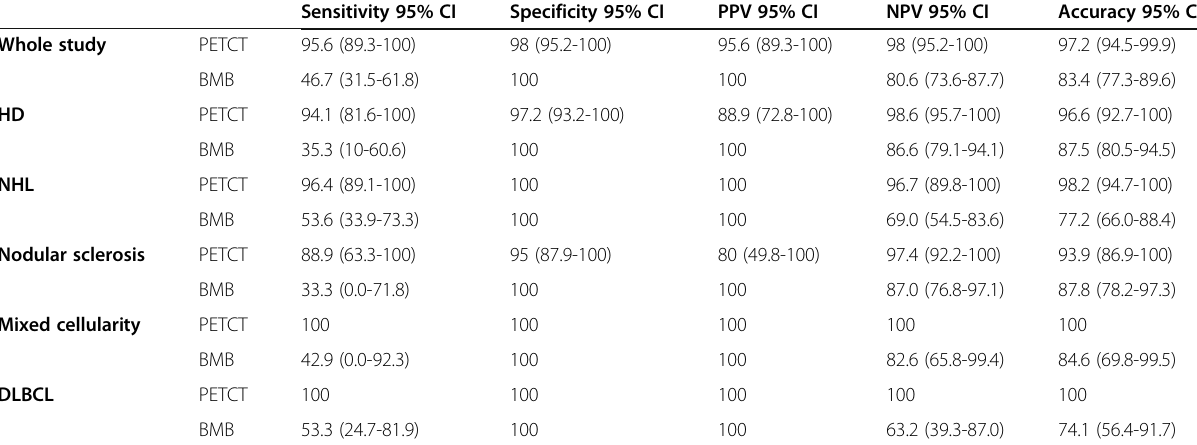
Table 7 Sensitivity, specificity, PPV, NPV, and accuracy of PET/CT and